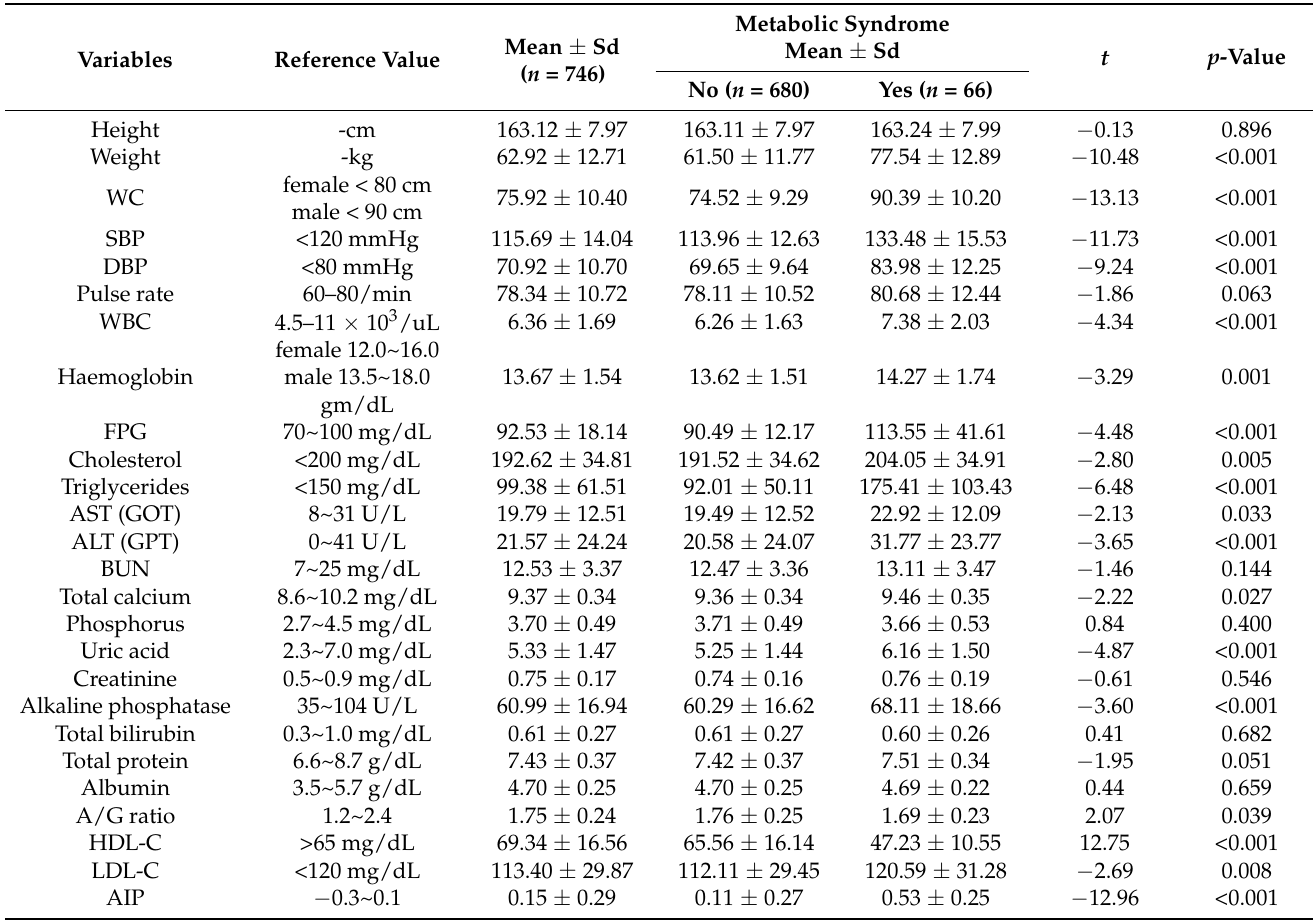
Table 2. Physical and biochemical values of the study population.